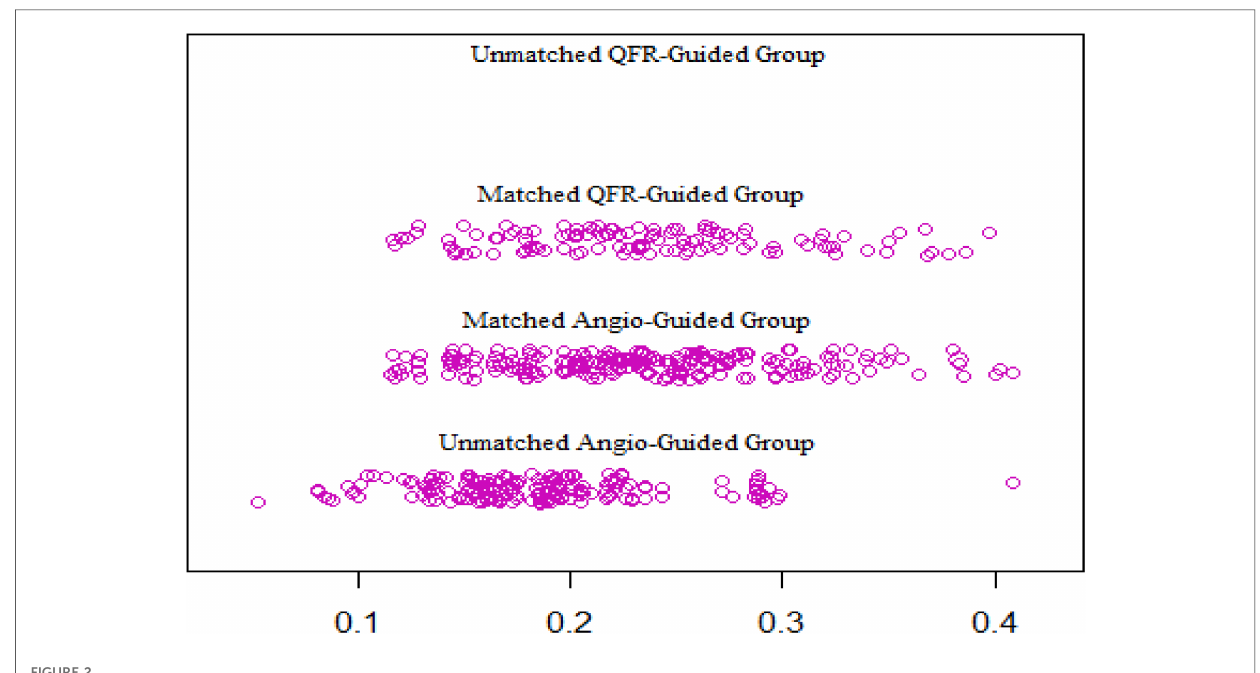
FIGURE 2 Distribution of the propensity scores.